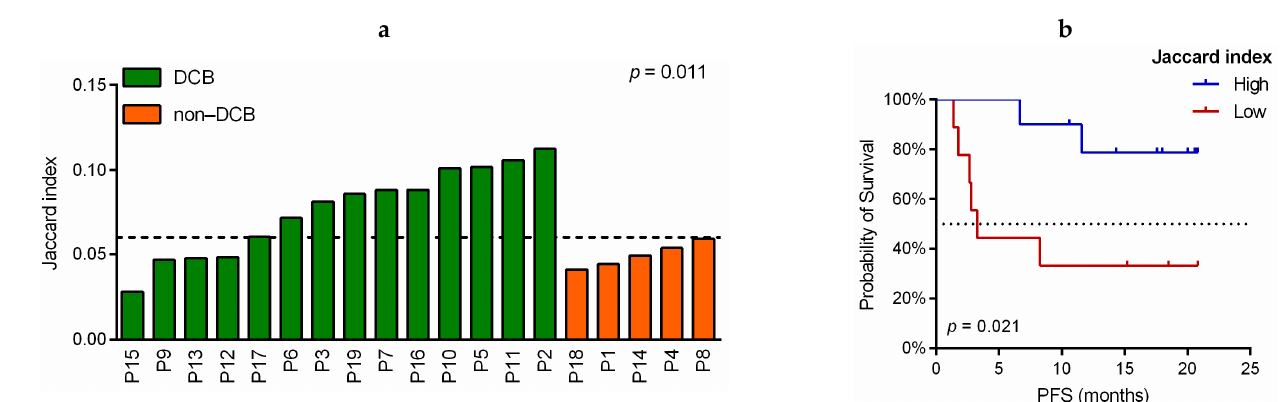
Figure 5. Correlation of TCR- β similarities before and during the anti-PD-1 treatment with response and prognostic variables in NSCLC patients. ( a ) Jaccard index in patients with durable clinical benefit (DCB; in green) and non-durable clinical benefit (non-DCB; in orange). p -value was obtained using the Fisher’s exact test. Each column represents a patient. ( b ) Kaplan–Meier progression-free survival (PFS) curves according to the Jaccard similarity index. Jaccard similarity index was calculated as the total number of shared clones divided by the total number of unique clones across PRE and FR samples of the same patient and the median = 0.0605 was used as the cutoff value to define high (blue line) and low (red line) groups. P -value was obtained using the log-rank test.